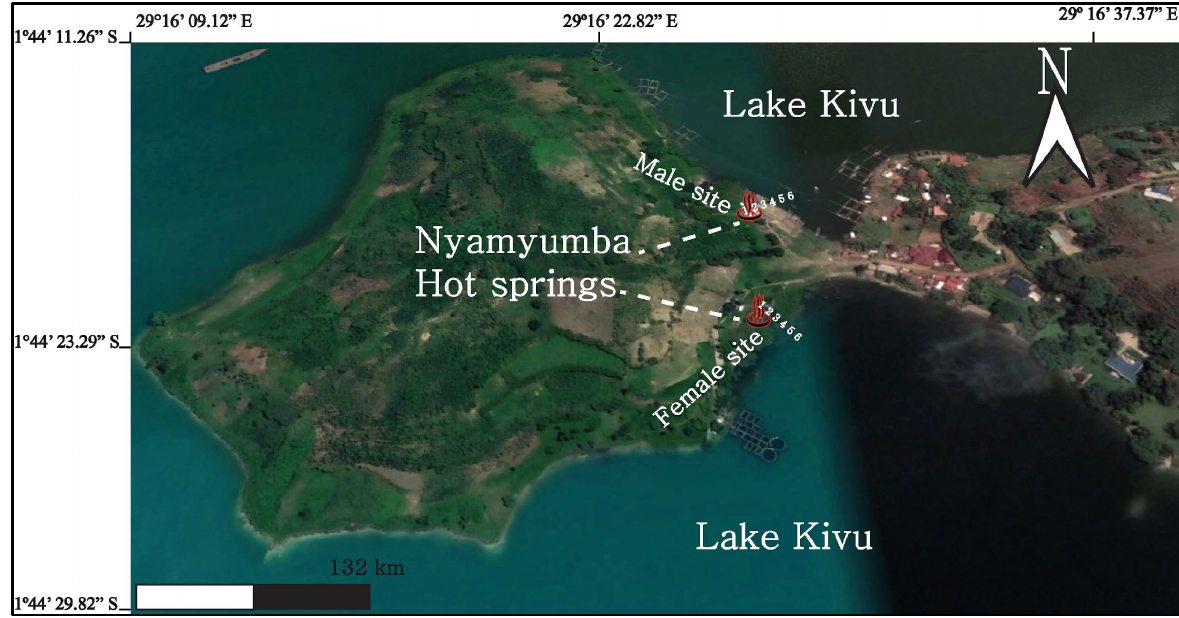
Figure 2. The location of Nyamyumba hot springs shows the location of the two sites (female and male) relative to Lake Kivu with corresponding longitude ( x -axis) and latitude ( y -axis). Names: the male and female names were named by local people based on the location reserved for males and females, respectively. Numbers from 1 to 6 represent the sampled locations. N: North, S: South, E: East.